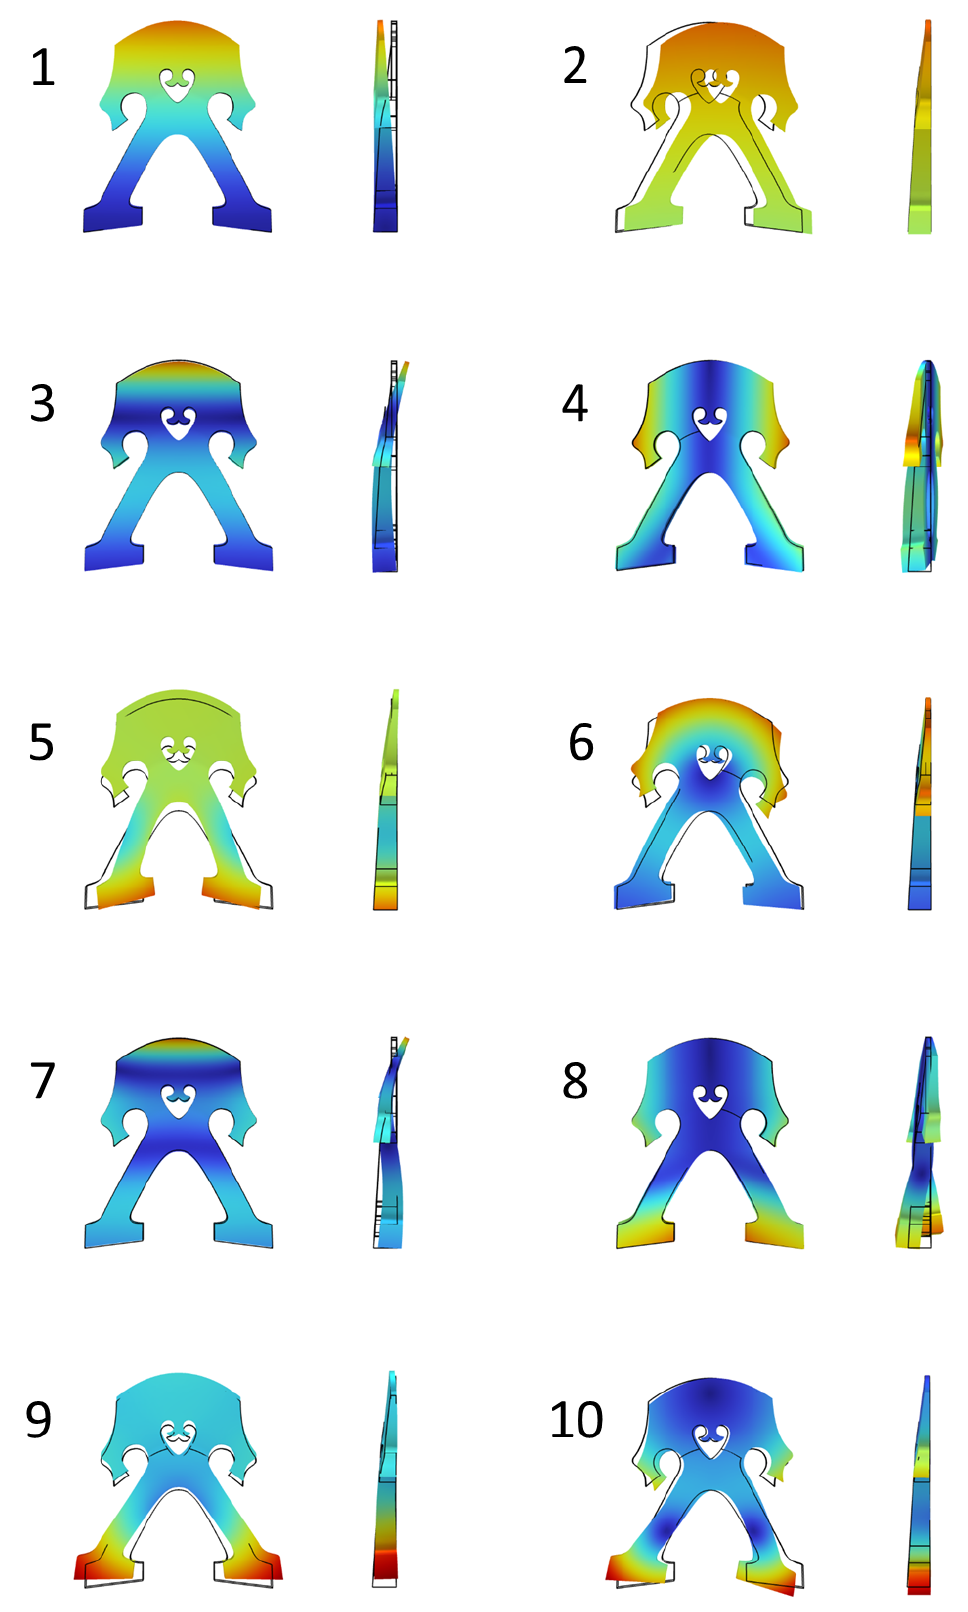
Figure A7. Mode shapes in spring boundary conditions (case (c)) for Model